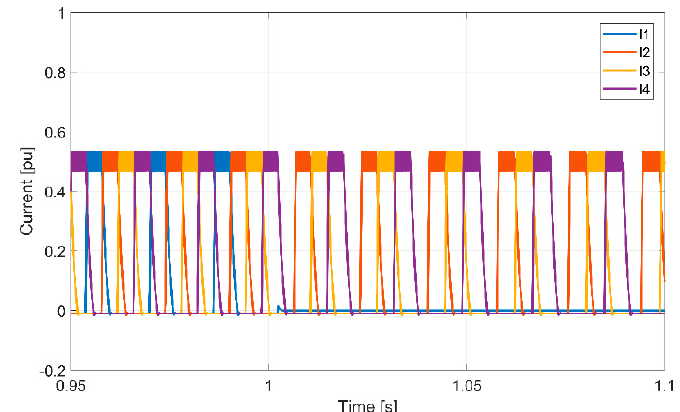
Figure 8. Motor winding currents of the SRM at 600 rpm in normal condition and open-circuit failure of power device S 1 A (simulation result).